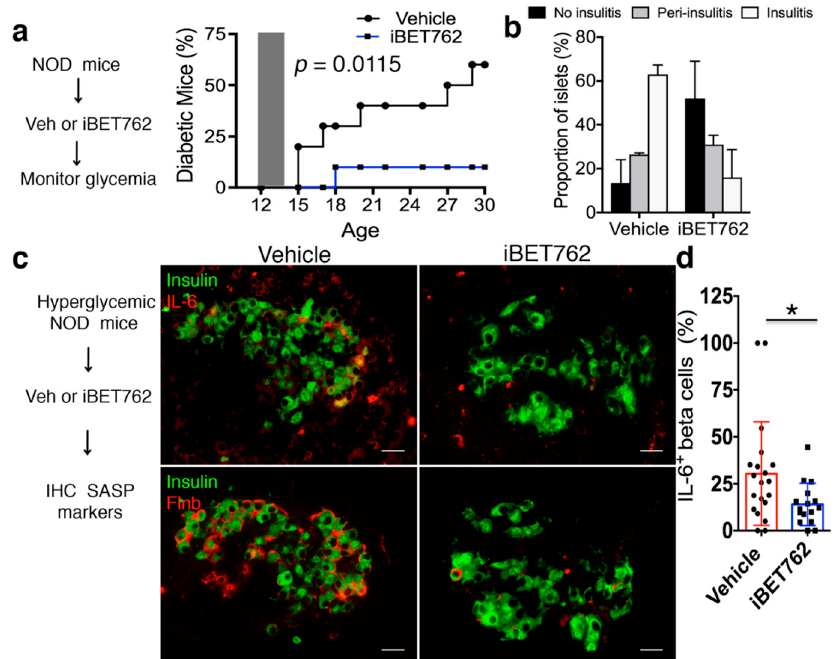
Figure 4. iBET-762 prevents diabetes and attenuates SASP in vivo. ( a ) Twelve-week-old NOD mice ( n = 10 per group) were administered vehicle or iBET-762 intraperitoneally (i.p.) for two weeks and glycemia was monitored up to 30 weeks of age. Diabetes incidence curves show the frequency of hyperglycemic mice at each time point. Gray shaded area shows treatment window (12–14 weeks of age). p = 0.0115, log-rank test. ( b ) Insulits grading in n = 30 islets taken from two euglycemic vehicle control and two euglycemic iBET-762 mice after the prevention study in ( a ) at 30 weeks. Error bars are SD. ( c ) Recent onset hyperglycemic NOD mice were administered vehicle or iBET-762 i.p. for one week and then IHC was performed for SASP markers. Representative IHC of SASP factors IL-6 or Flnb with insulin in pancreas sections from the indicated diabetic mice after treatment. Scale bars = 20 µ m. ( d ) Quantification of IL-6 + / Ins + cells per islet in the hyperglycemic NOD mice treated as in ( a ). Each dot represents an islet, where n = 20 islets for a total of 735 beta cells were scored from three vehicle-treated mice, and n = 16 islets for a total of 891 beta cells were scored from three iBET-762-treated mice. * p < 0.05, two-tailed t-test.